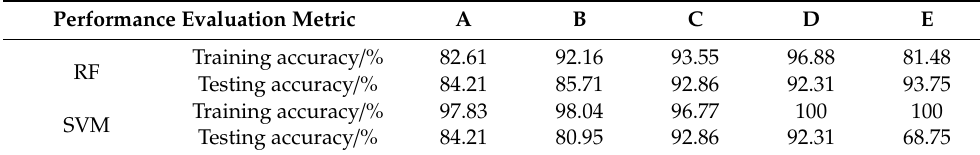
Table 3. Model performance for each